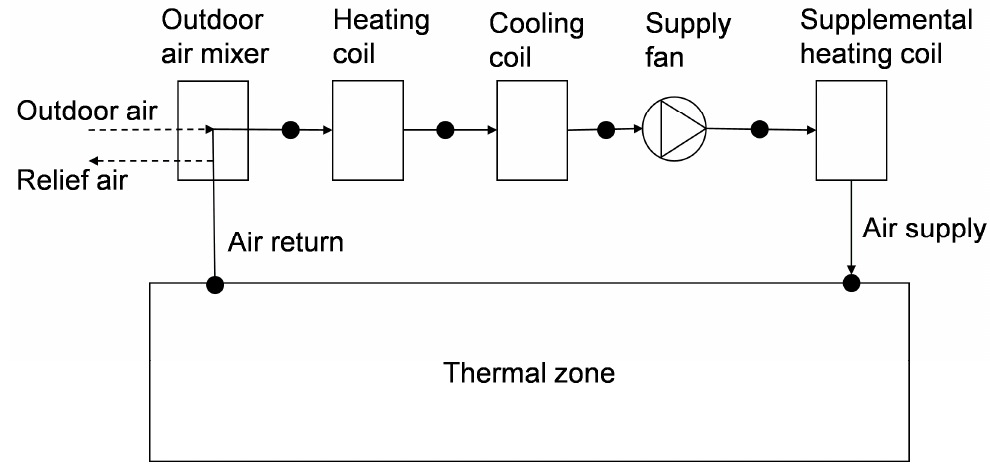
Figure 7. The sketch of the heat pump system [27].